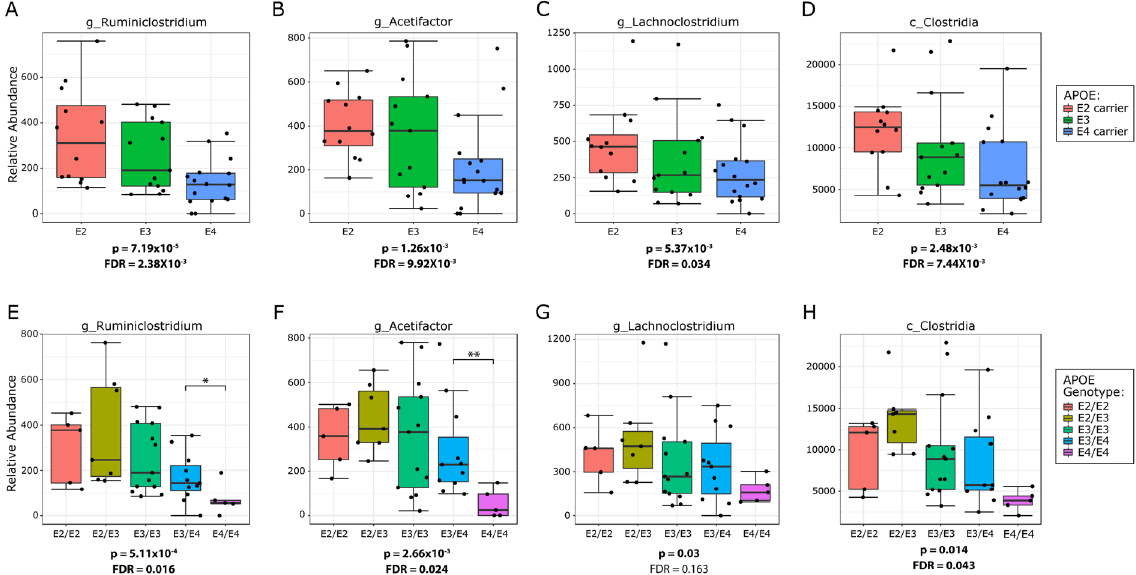
Figure 5. The phylogenetic branch defined by Clostridia and its lower taxa shows a significant association with APOE in male mice. The relative abundance of each depicted bacteria was significantly associated with APOE status. The relative abundance of these bacteria decreased in a stepwise fashion from APOE2 to APOE3 to APOE4 . P values have been corrected using an FDR approach. ( A–D ) Are the plots depicted using the dominant model representation, while ( E–H ) are the plots depicted using the co-dominant model representation. These data are derived from the 3-month male mice with data for all ages provided in Supplementary Tables S5.0–